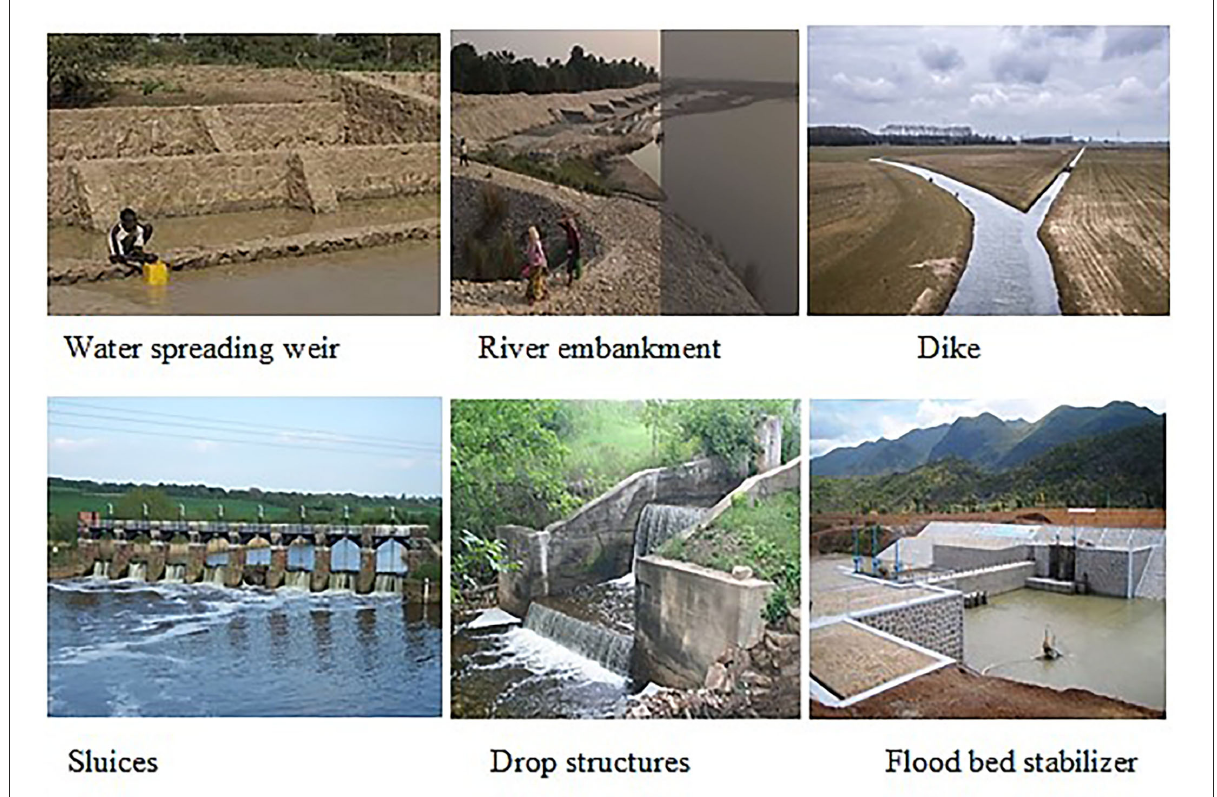
FIGURE9 Water re-direction infrastructure for flood-prone areas. Source: https://wle.cgiar.org/solutions/six-ways-increase-productivity-flood-based-